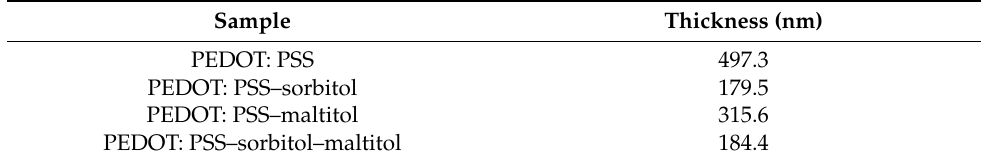
Figure 4. Scanning electron microscopy (SEM) micrograph of the cross sections of ( a ) PEDOT: PSS, ( b ) PEDOT: PSS–sorbitol, ( c ) PEDOT: PSS–maltitol, and ( d ) PEDOT: PSS–-sorbitol–maltitol.